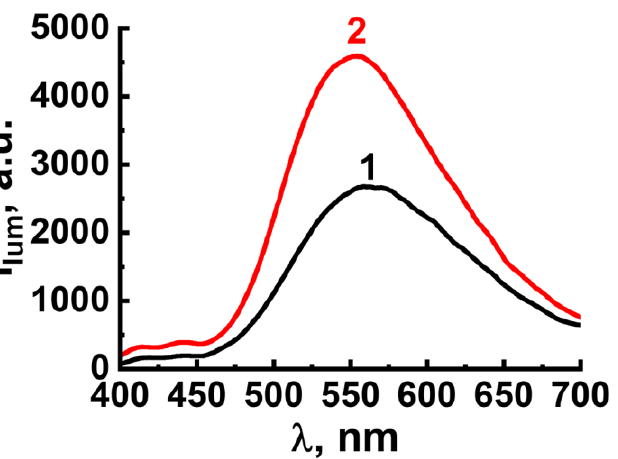
Figure 5. Solid-state emission spectra measured for the dried Cu 2 I 2 L 3 -based colloids at room temperature (1) and at 77K (2).